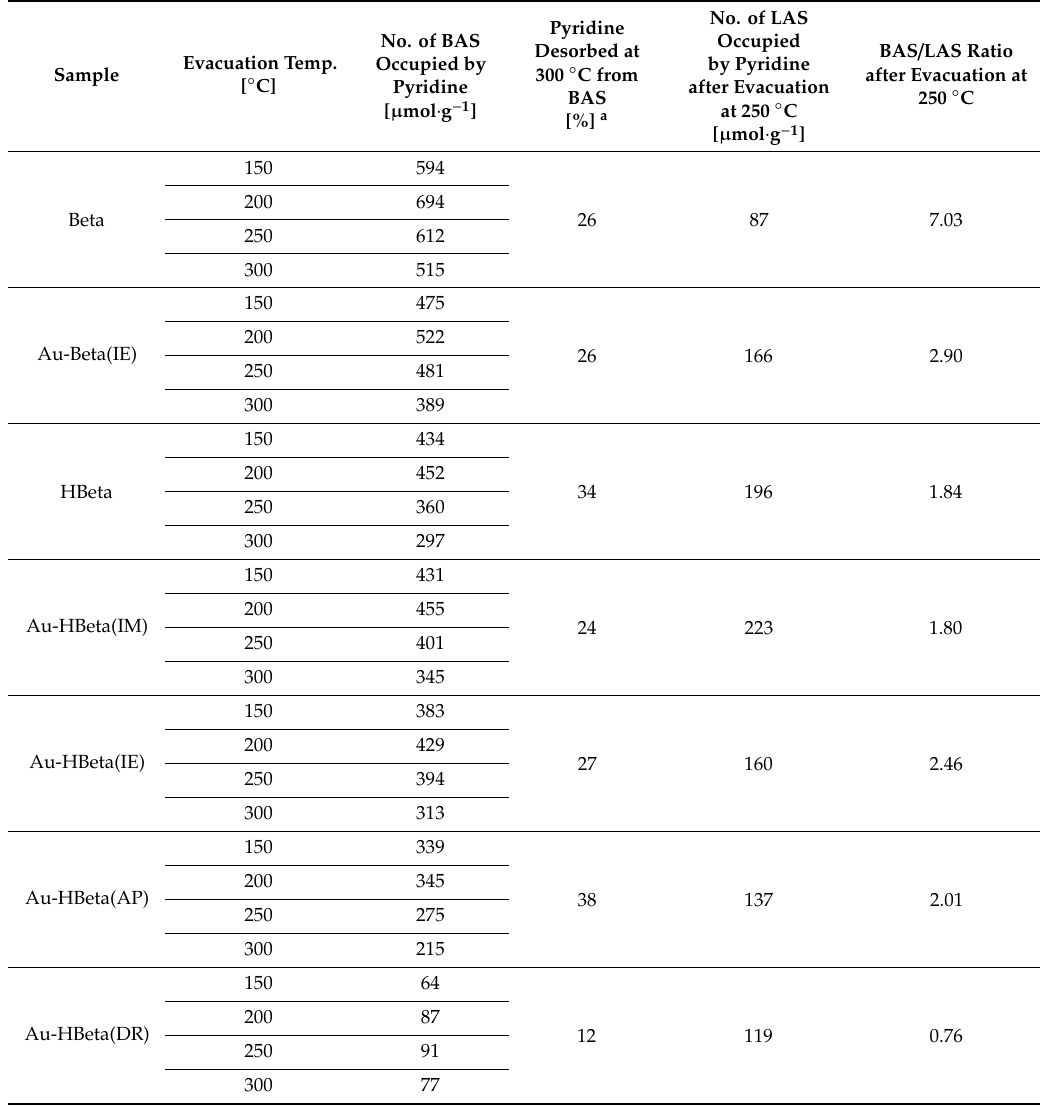
Table 3. Content of Brønsted (BAS) and Lewis (LAS) acid sites occupied by pyridine after desorption at di ff erent temperatures. The calculation based on intensity of IR bands (1545 cm − 1 for BAS and 1455 cm − 1 for LAS) and extinction coe ffi cients of 0.044 cm 2 µ mol − 1 for BAS and 0.165 cm 2 µ mol − 1 for LAS from